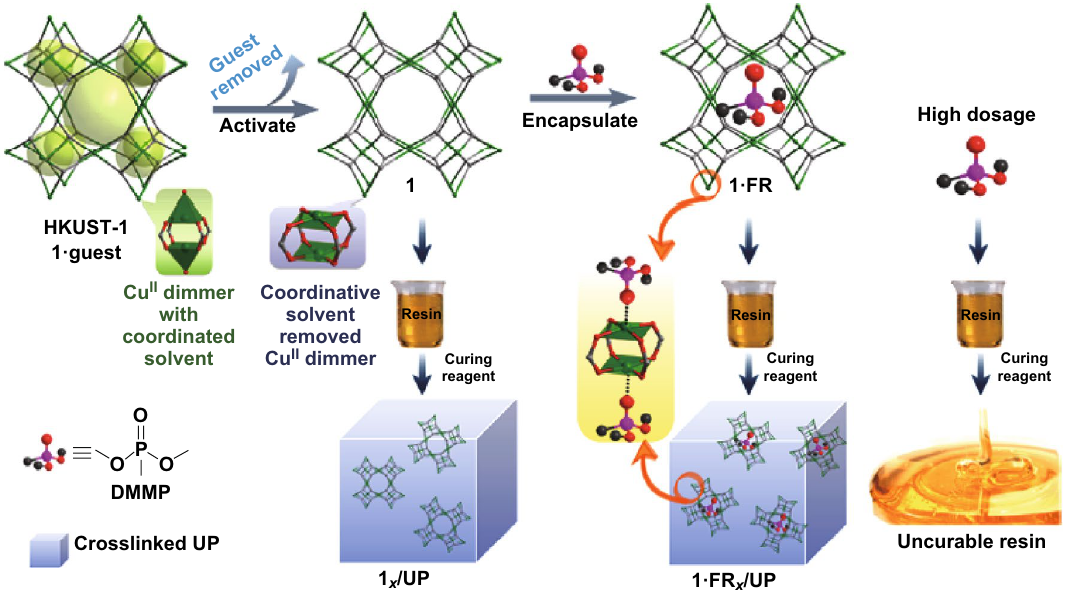
Fig. 20 Scheme for encapsulating FR into MOF and UP composite preparation [26]. Reproduced from Ref. [45] with permission from Ameri‑ can Chemical Society, https ://pubs.acs.org/doi/10.1021/acsam i.9b023 57. Further permission related to the material excerpted should be directed to the